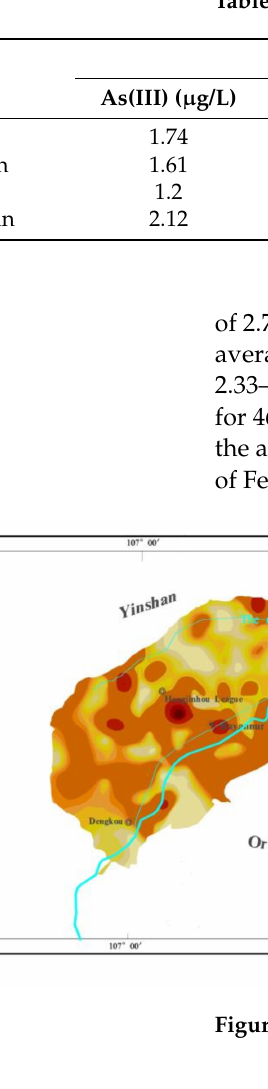
Table 3. As(III)/As(IV) ratios in shallow groundwater from Hetao Basin.